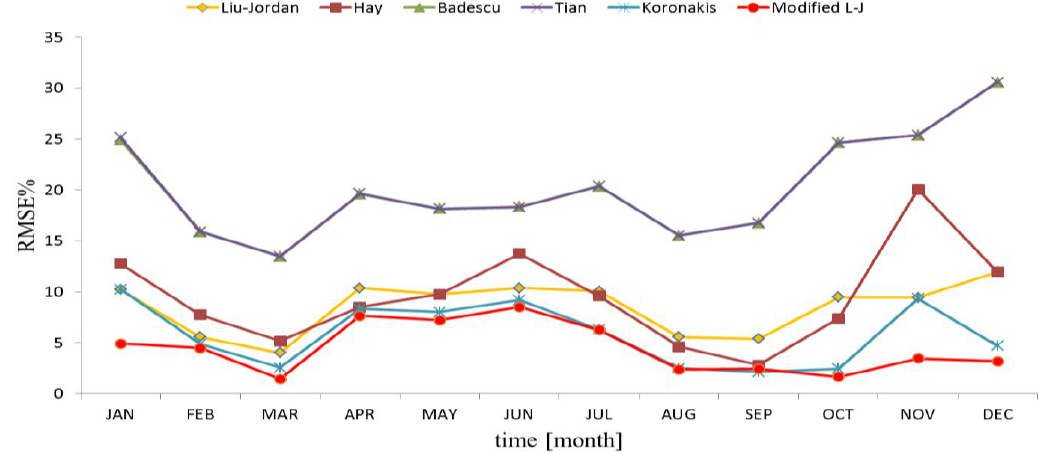
Figure 5. The differences in RMSE% of incident solar radiation of multiple models for a plane facing south at an inclination angle of 45° located in Poznań, Poland.